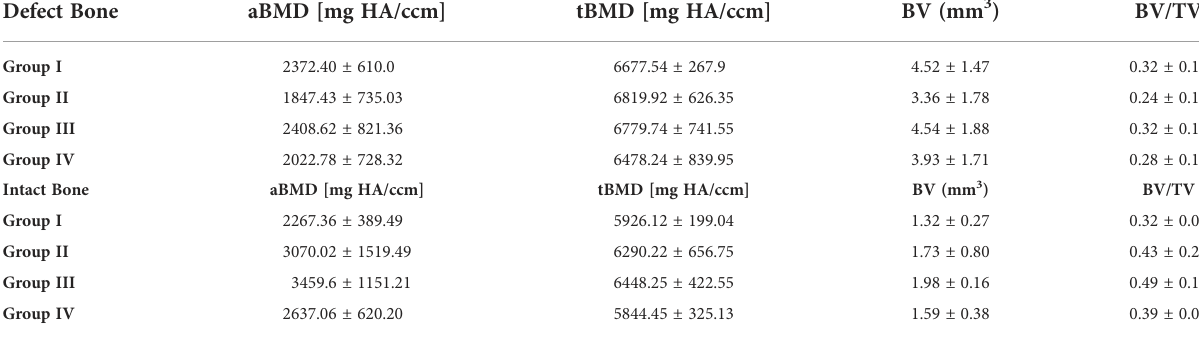
Group III had signi fi cantly greater apparent bone mineral density (aBMD) compared to Groups I and IV (p=0.009 and p=0.0467). For remaining parameters of total bone mineral density (tBMD), bone volume (BV) and total volume (TV) there were signi fi cant differences between intact and defect bone (p=0.0002, p<0.0001, and p<0.0001, respectively), but no signi fi cant differences between treatment